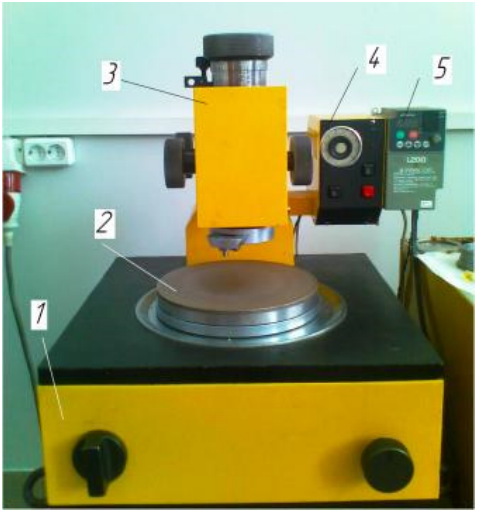
Figure 1. Lapping machine “Raster 220”. 1—drive unit, 2—Lapp, 3—pressure device, 4—control panel, 5—frequency converter. Table 1. Basic numerical data of the machine .